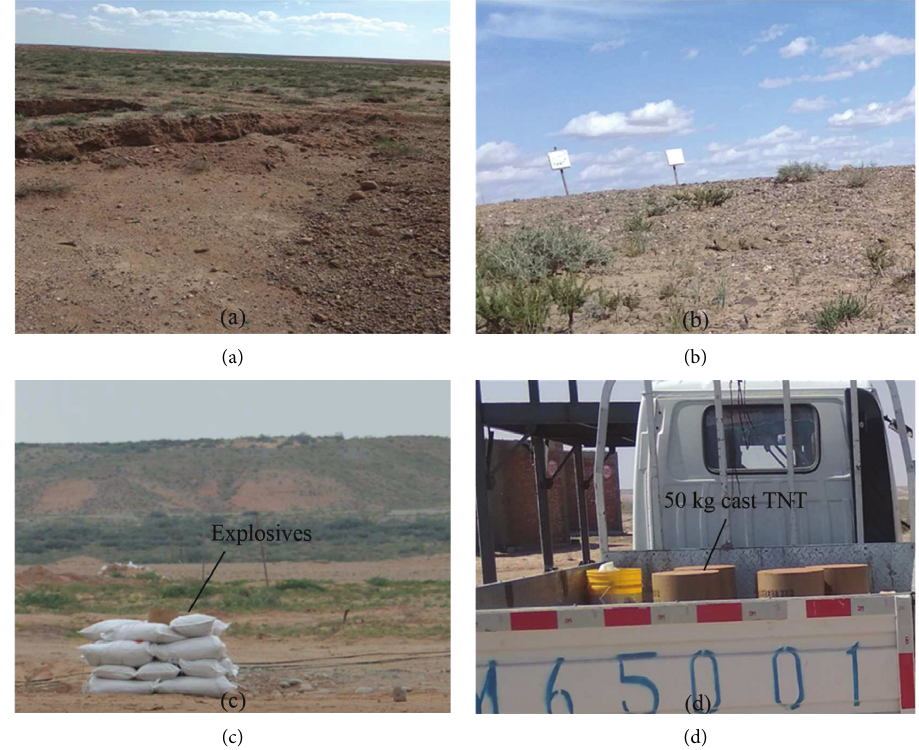
Figure 2: Photographs of the test area (a, b). The explosives and cast TNT used on the test site (c, d).